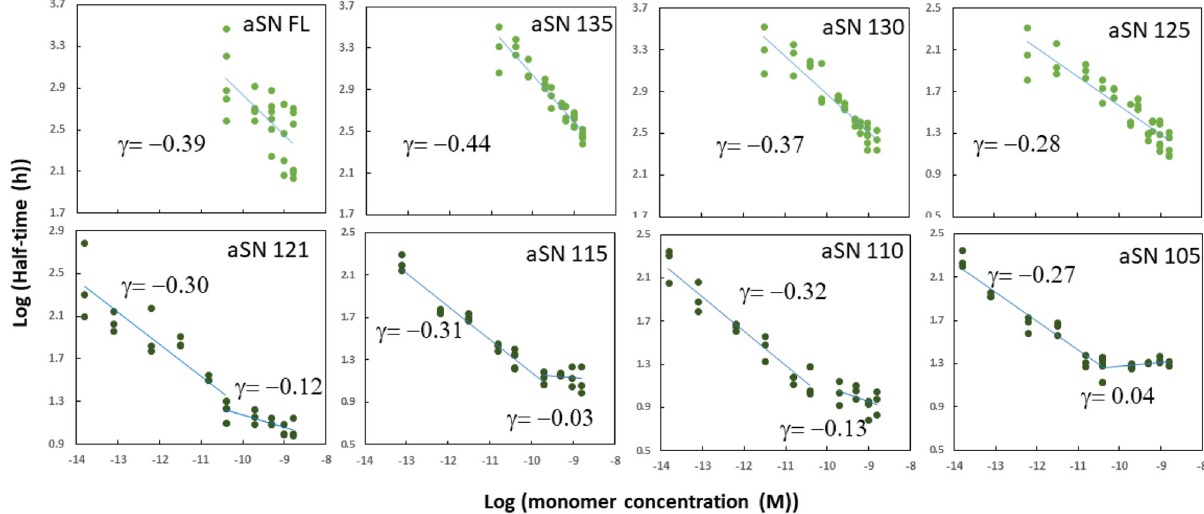
Fig. 1 Effect of C-terminal truncation on α SN fi brillation. Log-log plots of fi brillation half-times versus concentrations whose slope provides the scaling exponent γ . The plots reveal a single linear correlation for α SN125 and longer constructs and the growing prominence of a fl at region at high protein concentration for shorter constructs. Each point represents the half-time of a ThT curve (i.e., the time to reach half the maximal fl uorescence value) from a fi brillation experiment carried out at the indicated α SN